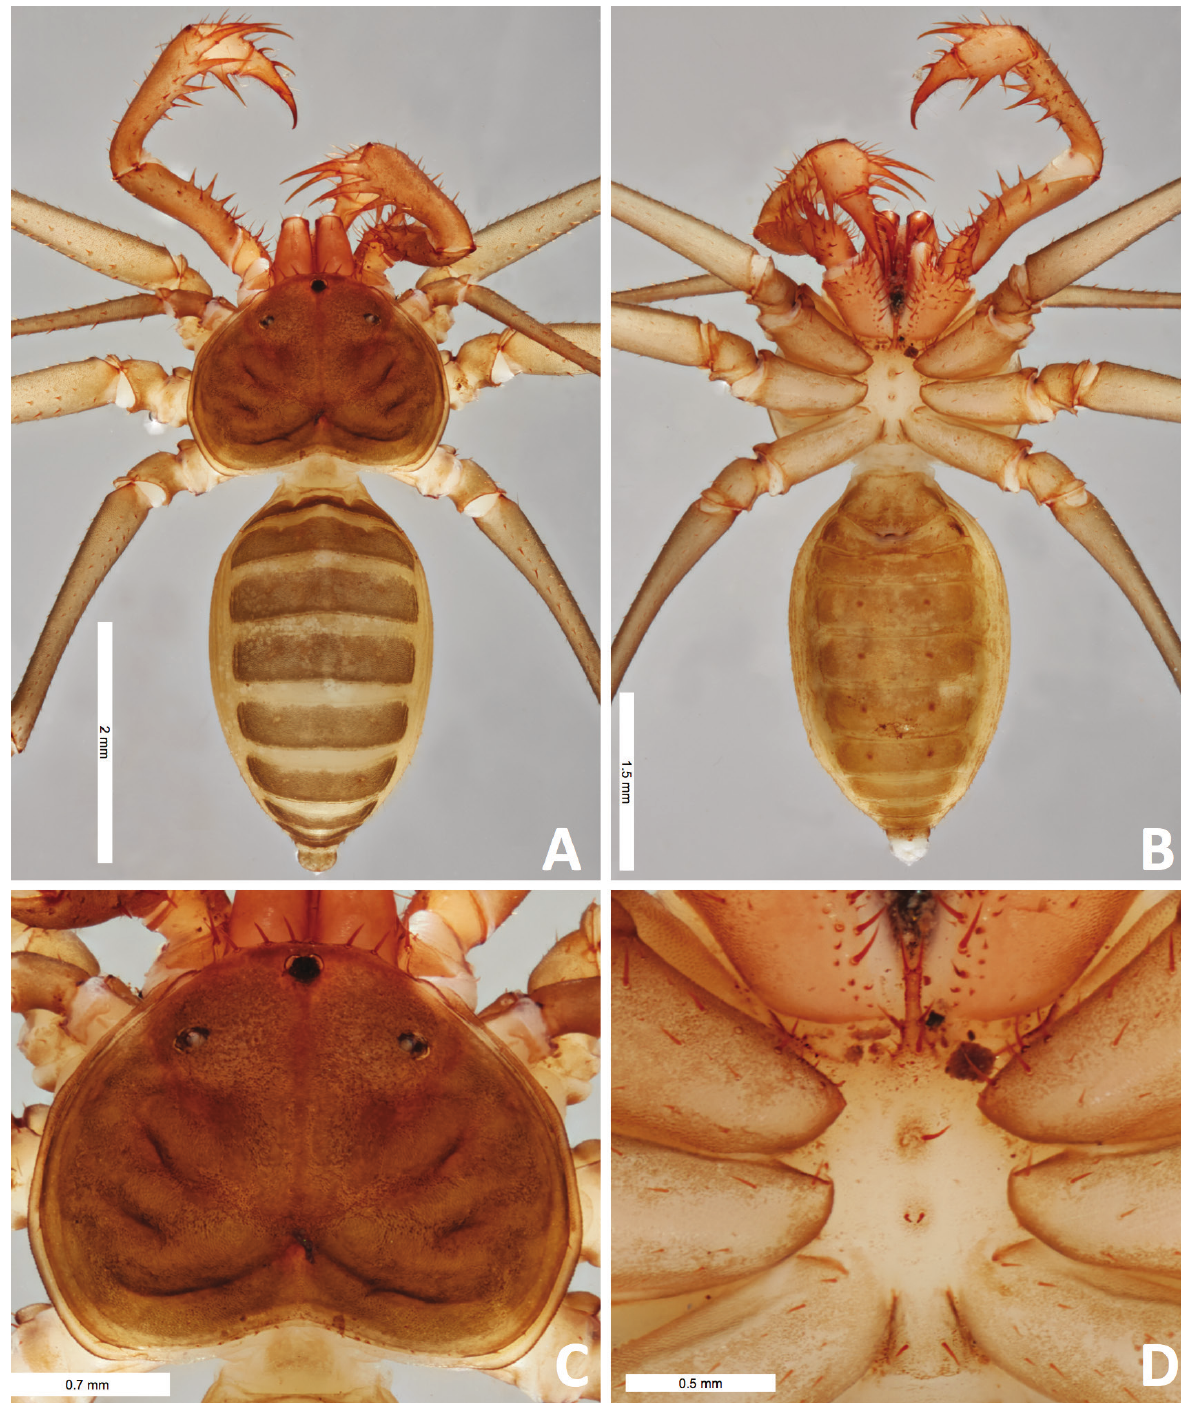
Figure 3. Female holotype of Charinus kakum sp. n.: A , details of habitus in dorsal view; B , details of habitus in ventral view; C , carapace in dorsal view; D , prosomal sternites in ventral